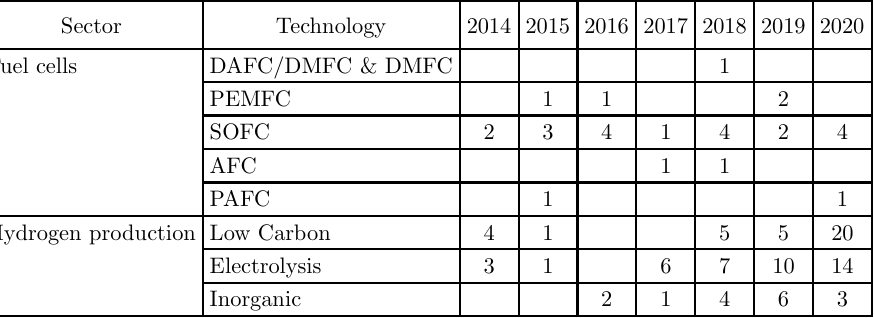
Patent registrations in technology of fuel cells and hydrogen production in Poland